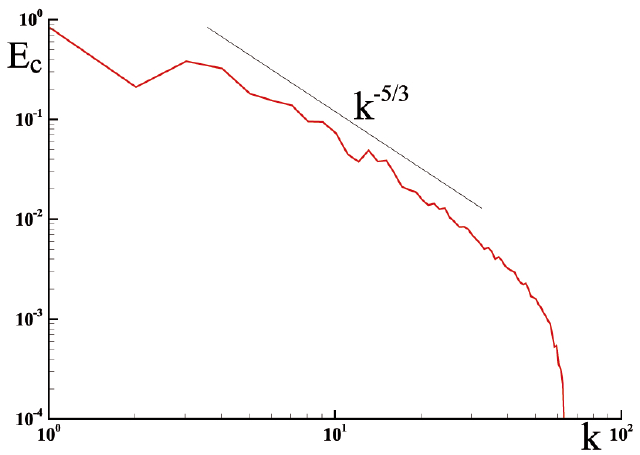
Figure 9. Energy spectrum as a function of the wave number E k ( k ) for t = 20 on one-quarter of the domain.